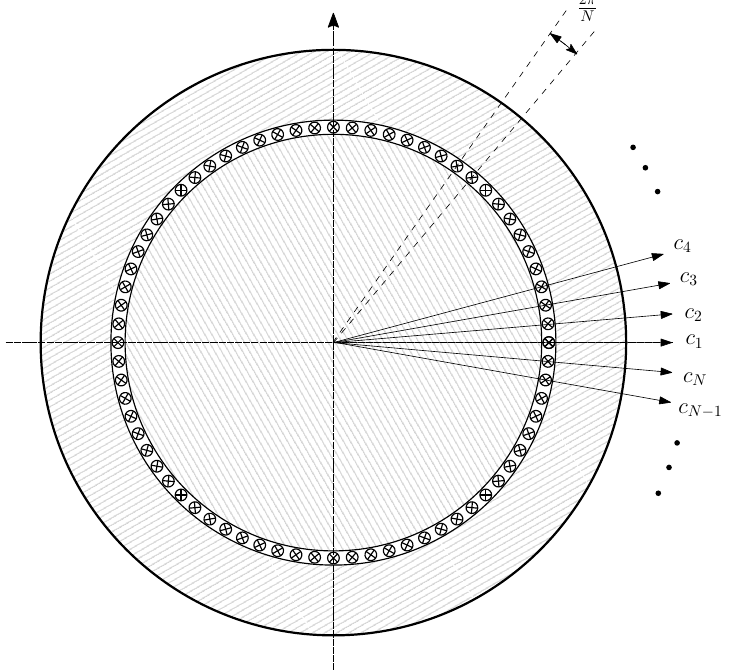
Figure 5. Reference frame constituted by N independent conductors placed in the air gap. The N components of the air gap current tensor in this system, i c , are the currents through each elemen- tary